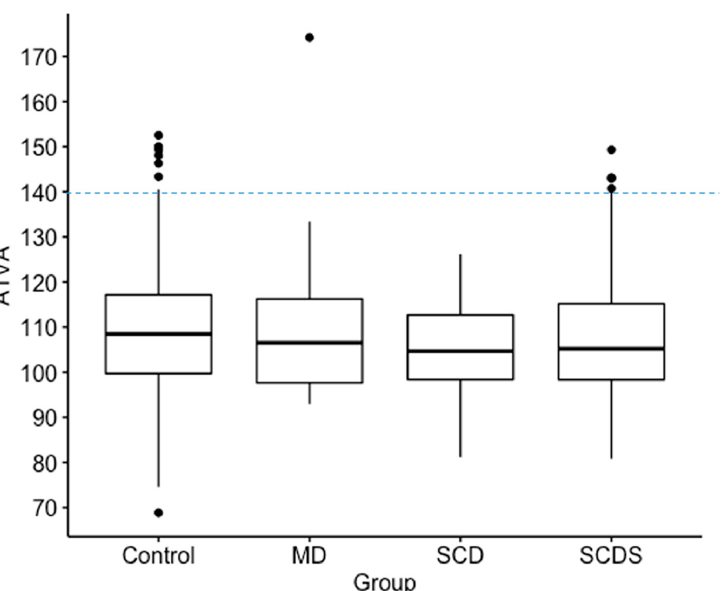
Figure 3. Box plots show median, interquartile range and outliers for angle of the vestibular aqueduct (ATVA). A cut-off line is shown at 140 degrees for defining abnormal as previously defined. No significant differences in a exit of the vestibular aqueduct was found among Meniere’s Disease (MD), superior canal dehiscence (SCD), superior canal dehiscence syndrome (SCDS), and control groups. In this figure, “Control” refers to patients without diagnosis of MD, SCD, or SCDS. 3.3. ATVA: SCD vs. SCDS The 𝑎 (cid:3032)(cid:3051)(cid:3036)(cid:3047) among patients with a radiologically identified superior canal dehiscence, patients diagnosed with superior canal dehiscence syndrome, and patients diagnosed with Meniere’s Disease were compared. Median and interquartile range values for 𝑎 (cid:3032)(cid:3051)(cid:3036)(cid:3047) were not significantly different among the three groups (Patients without MD or dehis- cence: 108 (17.4) degrees, n = 407; Superior Canal Dehiscence: 105 (14.3) degrees, n = 32; Superior Canal Dehiscence Syndrome = 105 (16.8) degrees n = 112; Meniere’s Disease = 107 (18.6) degrees, n = 21) (Figure 3). Pairwise comparisons were therefore not performed. 4. Discussion The aim of this study was to determine the distribution of vestibular aqueduct angles in a large population of individuals with a variety of otologic diagnoses and to examine whether other inner ear disorders like SCDS may have a hypoplastic vestibular aqueduct. Nearly all individuals in this study fell within the normal range for the angle of the ves- tibular aqueduct and 11 had a diagnosis of clinical Meniere’s disease. None of the affected ears of patients with Meniere’s disease in this study met the criteria for a hypoplastic ves- tibular aqueduct. Furthermore, no significant differences were found in the vestibular aq- ueduct angles among the patients with Meniere’s disease, patients with solely an anatomic superior canal dehiscence diagnosed on imaging, and patients with superior canal dehis- cence syndrome. Among all CT scans, we found 13 patients (14 ears) with a vestibular aqueduct that exceeded the 140 degrees angle cutoff set by Bächinger et al. for patients with hypoplastic Meniere’s disease pathology, yet none of those patients had Meniere’s disease in the affected ear (Figure 3). One of the ears with ATVA > 140 degrees was from a patient with a diagnosis of Meniere’s Disease, but that diagnosis applied to the contra- lateral ear. Three of the ears with 𝑎 (cid:3032)(cid:3051)(cid:3036)(cid:3047) > 140 had a diagnosis of SCDS, and the other 9 ears